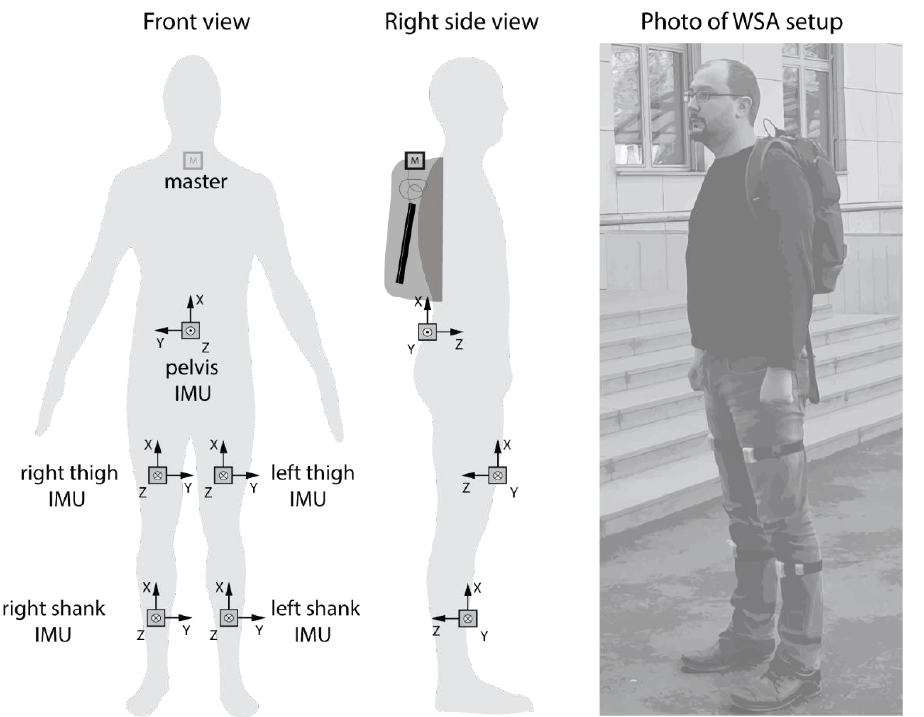
(1) at the bottom of the backpack, (2) at the bottom edge of the backpack, (3) at the bottom back of the backpack, (4) at the back of the backpack, (5) at the top edge of the backpack, (6) at the top of the backpack, (7) in a static position on the table 1.5 m behind the subject at a height of 0.7 m, and (8) firmly attached to the subject’s back without the backpack. The laboratory test was conducted as a baseline, with the devices spaced 1.5 m apart. Tests (1) to (6) were performed during a walk in a public hall, while conditions (6) to (8) were checked when walking on a treadmill. Each session lasted for 10 min. The sampling rate was 100 Hz on each IMU unit and for each variable.